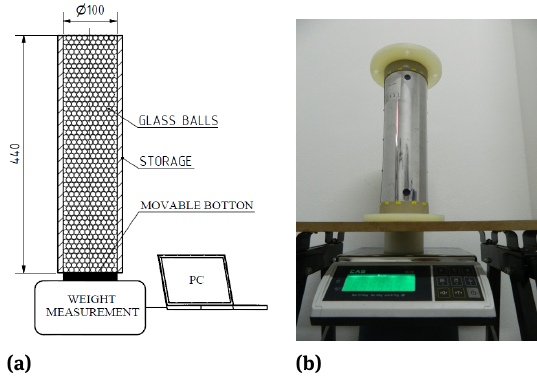
Figure 6: Diagram of the measurement stand: a) scheme of measure- ment stand, b) real measurement